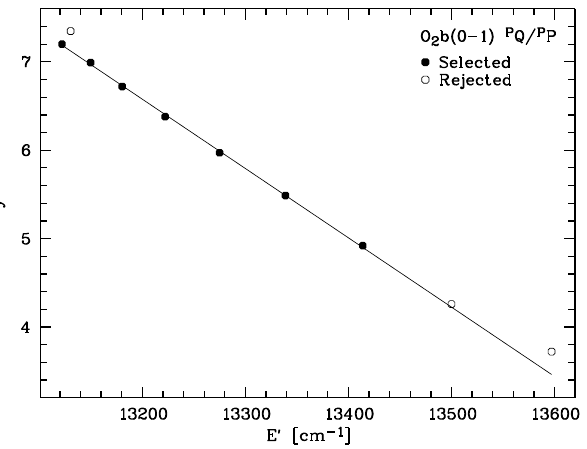
Figure 5. Median X-shooter spectrum of O 2 a (0-0) for the 177 NIR- arm sample spectra taken with the standard slit width of 0.9 (cid:48)(cid:48) . S R and O P lines with odd upper rotational levels N (cid:48) from 13 to 23 are marked by circles and diamonds, respectively. The filled symbols indicate lines that were used for the derivation of T rot